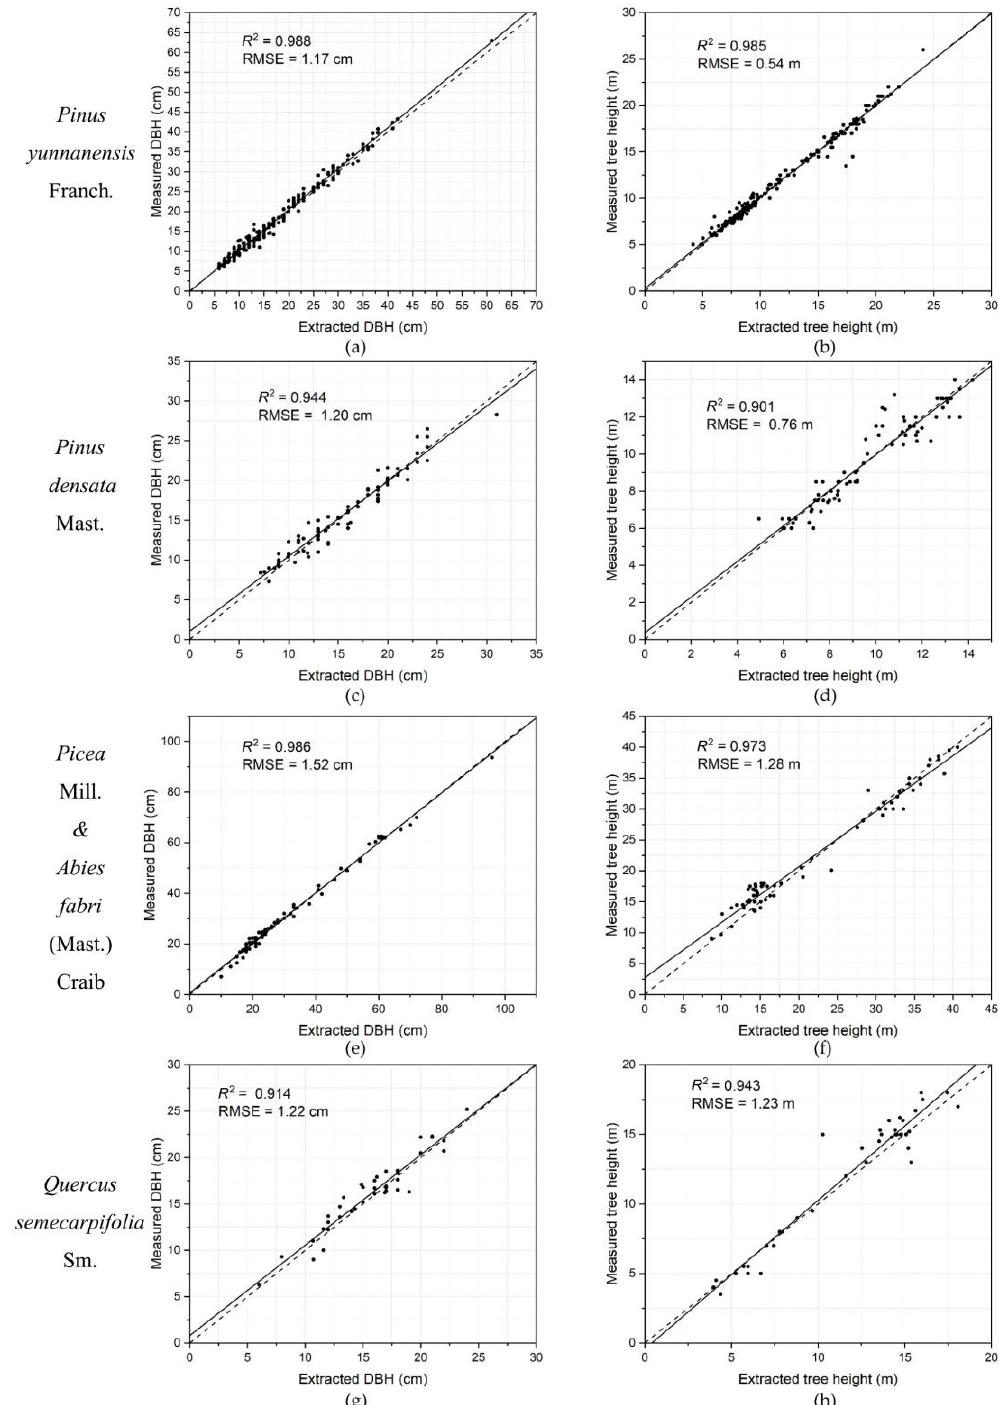
Figure 10. Accuracy analysis of four dominant forest species in Shangri-La. ( a ) Pinus yunanensis ; ( b ) Pinus densata ; ( c ) Picea & Abies fabri ; ( d ) Quercus semecarpifolia